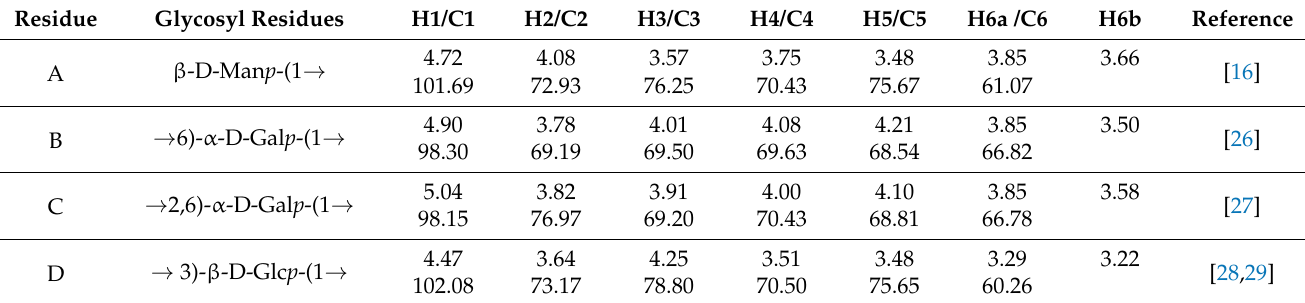
Table 2. 1 H and 13 C NMR chemical shifts for